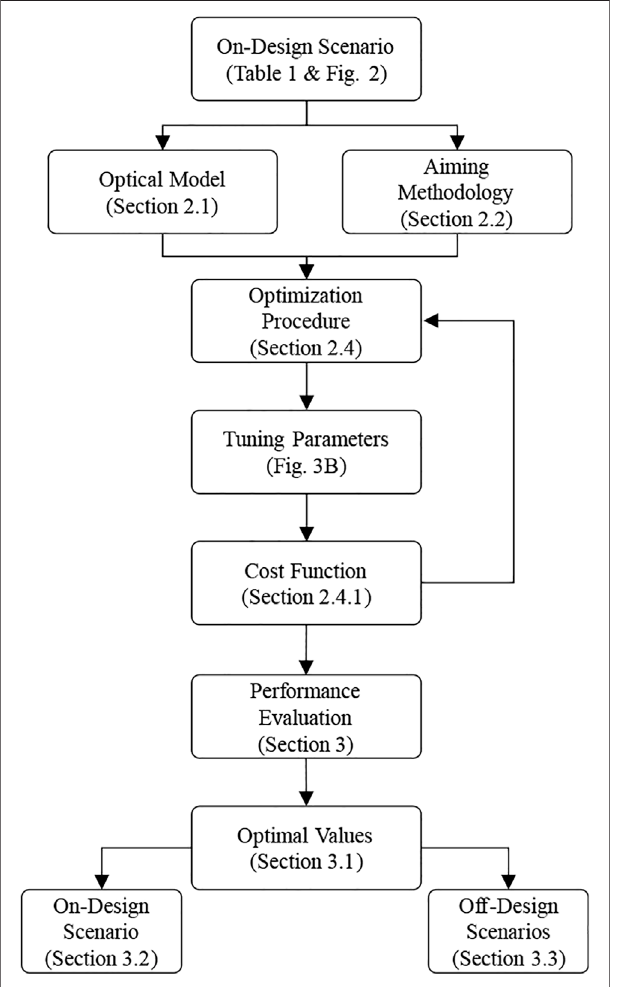
FIGURE 1 | The methodology adopted in this study.